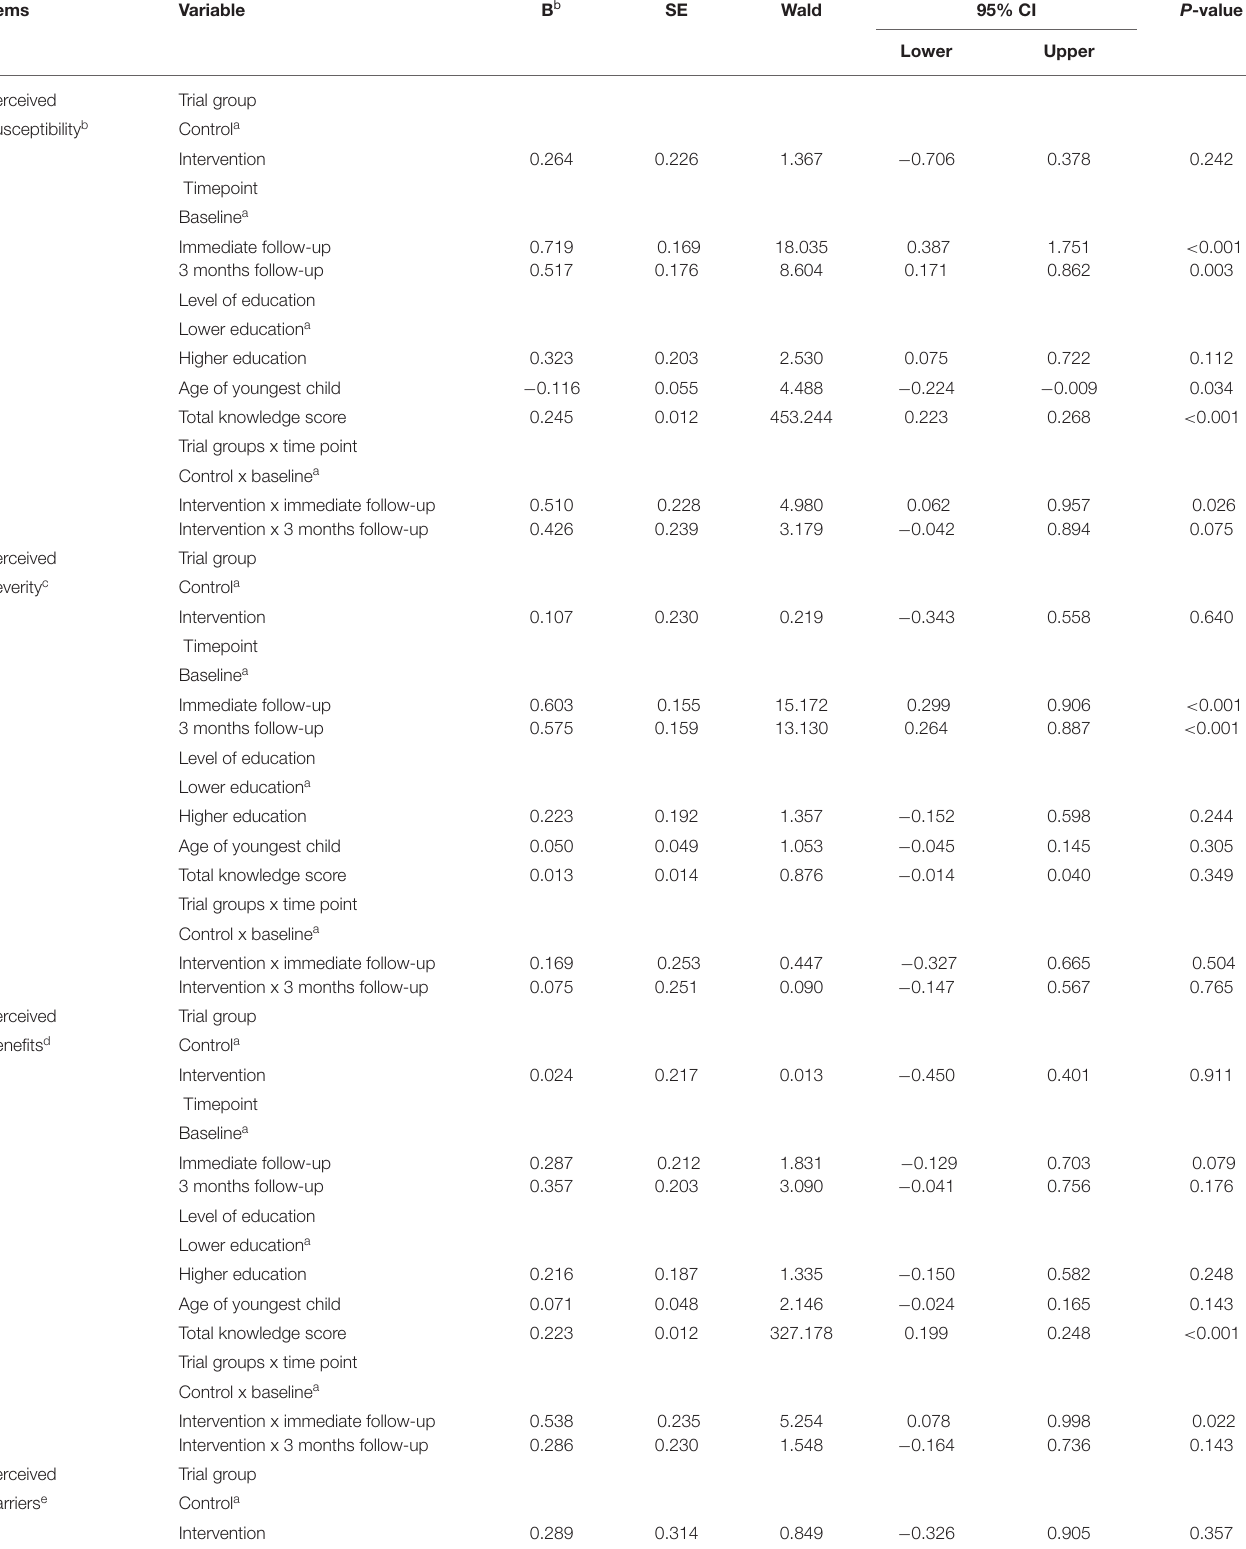
TABLE 2 | Effectiveness of the module on perceived susceptibility, severity, benefits, barriers, and preschool children’s handwashing practice.